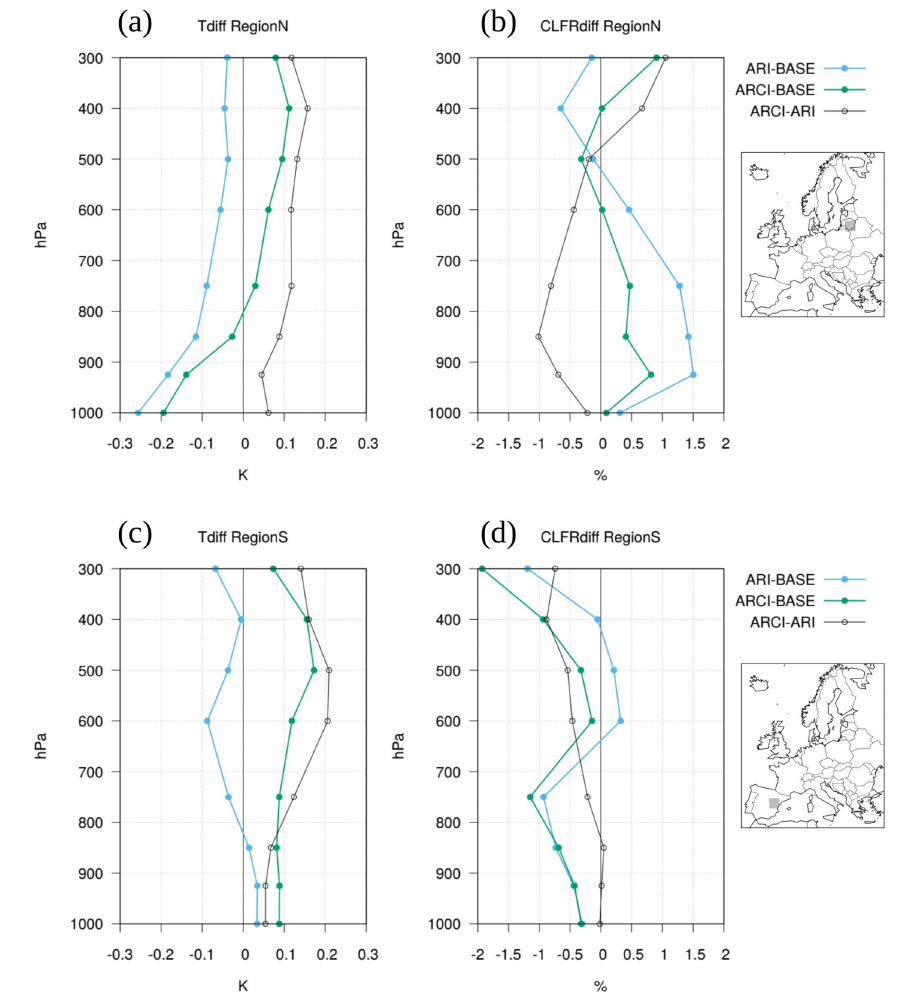
Figure 4. Vertical profiles of the spatial mean differences in summer (JJA) mean air temperature ( T , a , c ) and cloud fraction (CLFR, b , d ) in the historical period (1991–2010) between experiments over two small areas: a northern one (region N; a , b ) and a southern one (region S; c , d ), which are shaded gray in the respective maps. These are plain differences, with units of Kelvin (K) for T and percent for